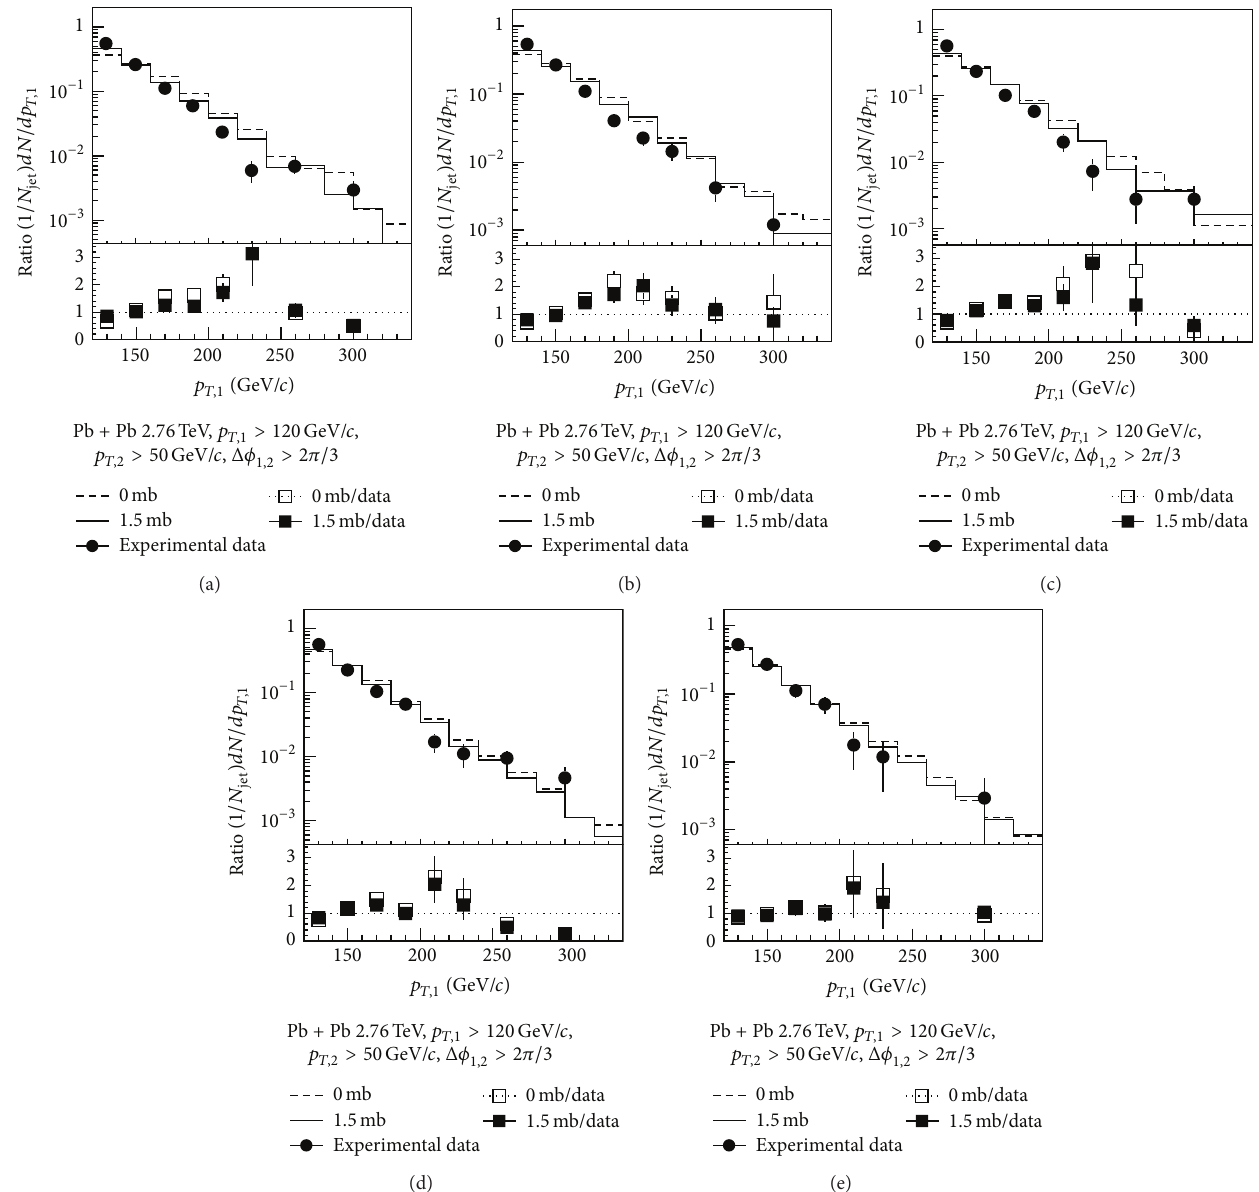
Figure 1: Leading jet 𝑝 𝑇 distributions for dijet events with subleading jets of 𝑝 𝑇,2 > 50 GeV/c in Pb + Pb collisions at √𝑠 𝑁𝑁 = 2.76 TeV for five centrality bins: (a) 0–10%, (b) 10–20%, (c) 20–30%, (d) 30–50%, and (e) 50–100%, where the solid (1.5 mb) and dash (0mb) histograms representtheAMPTresultswithpartonic+hadronicinteractionsandhadronicinteractionsonly,respectively,whilethesolidcirclesrepresent the data from the CMS experiment [10]. The lower part in each panel depicts the ratios of AMPT results to experimental